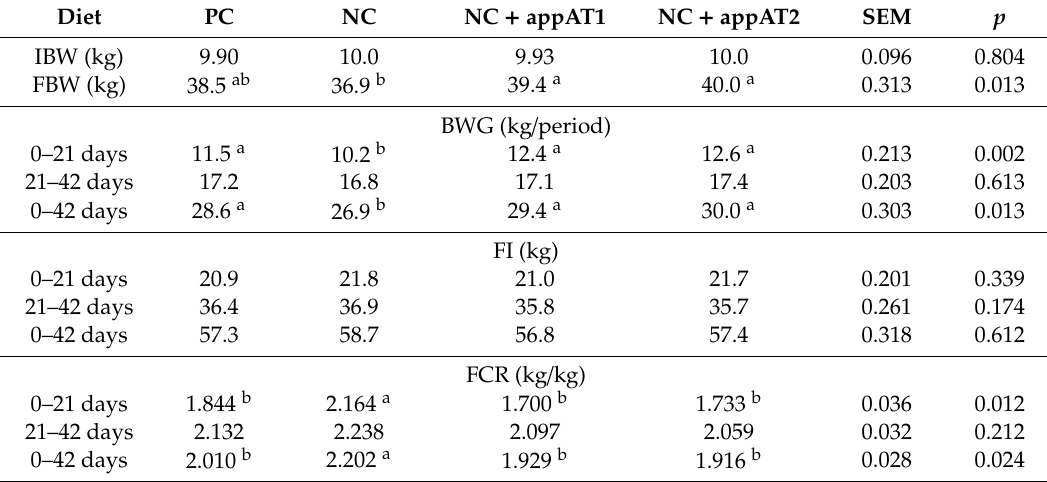
Table 4. Initial body weight (IBW), final body weight (FBW), body weight gain (BWG), feed intake (FI), and feed conversion ratio (FCR) of piglets fed the positive control (PC), negative control (NC), or NC diets supplemented with phytase (appAT1 or appAT2; n = 12).